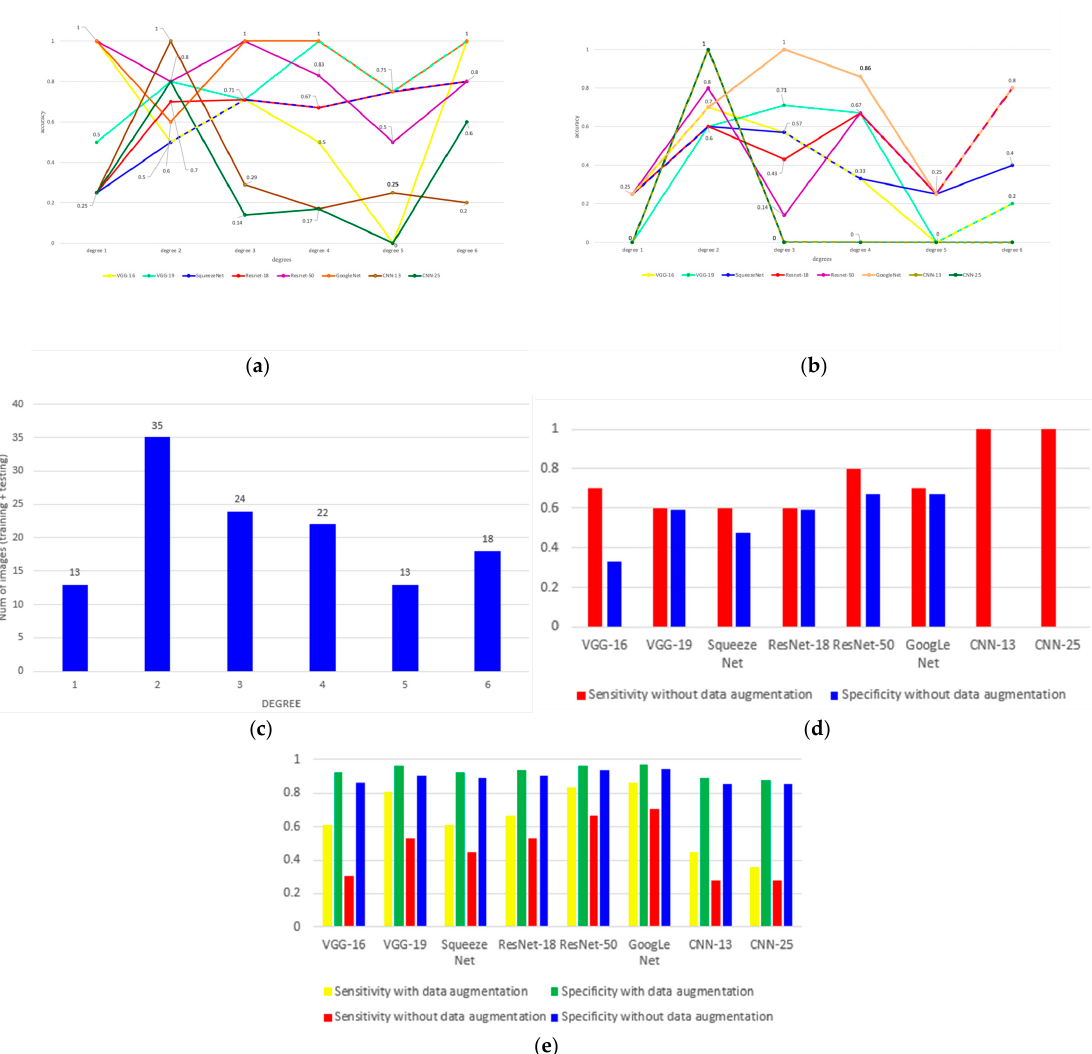
Figure 9. The accuracy in each degree with different models, where red dots represent the accuracy of VGG-16, green dots represent the accuracy of VGG-19, blue dots represent the accuracy of SqueezeNet, yellow dots represent the accuracy of ResNet-18, purple dots represent the accuracy of ResNet-50, orange dots represent the accuracy of GoogLeNet, rosy-brown dots represent the accuracy of CNN-13, and khaki dots represent the accuracy of CNN-25. ( a ) Accuracy over each degree with augmentation. ( b ) Accuracy over each degree without augmentation. ( c ) The dataset distribution contains both the testing set and the training set. ( d ) Comparison of sensitivity and specificity over each method with and without data augmentation on degree 2 only. ( e ) Comparison of average sensitivity and specificity over each method with and without data augmentation over all degrees.